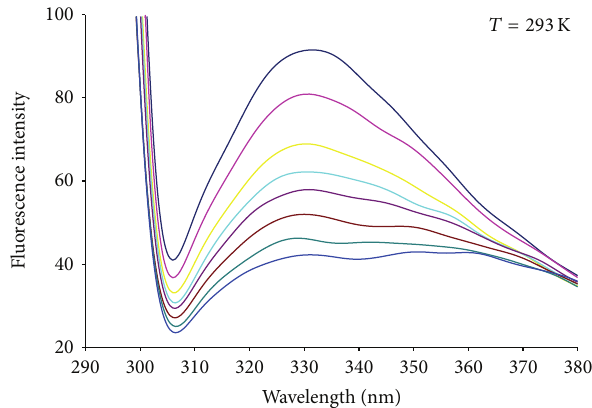
Figure 2: The fluorescence emission spectra of HAase in the pres- ence of increasing amounts of liquiritigenin. Peak from up to down = (0, 4.0, 8.0, 12.0, 16.0, 20.0, 24.0, 30.0) × 10 −6 molL −1 , 𝐶 liquiritigenin = 2.0 × 10 −6 mol L −1 . 𝐶 HAase